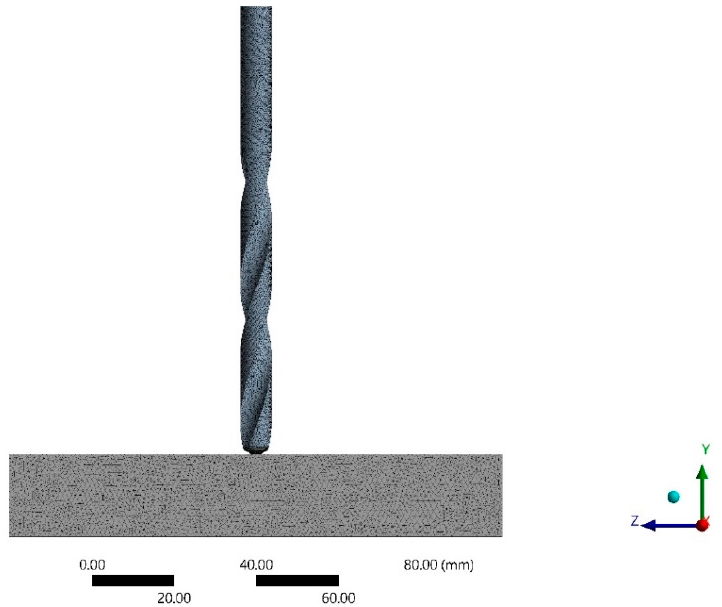
Figure 2. Meshed computational domain with a mesh count of 4.25 million cells.